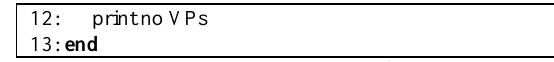
Figure 3 . Place recognition algorithm (Lv, Chen et al. 2016)